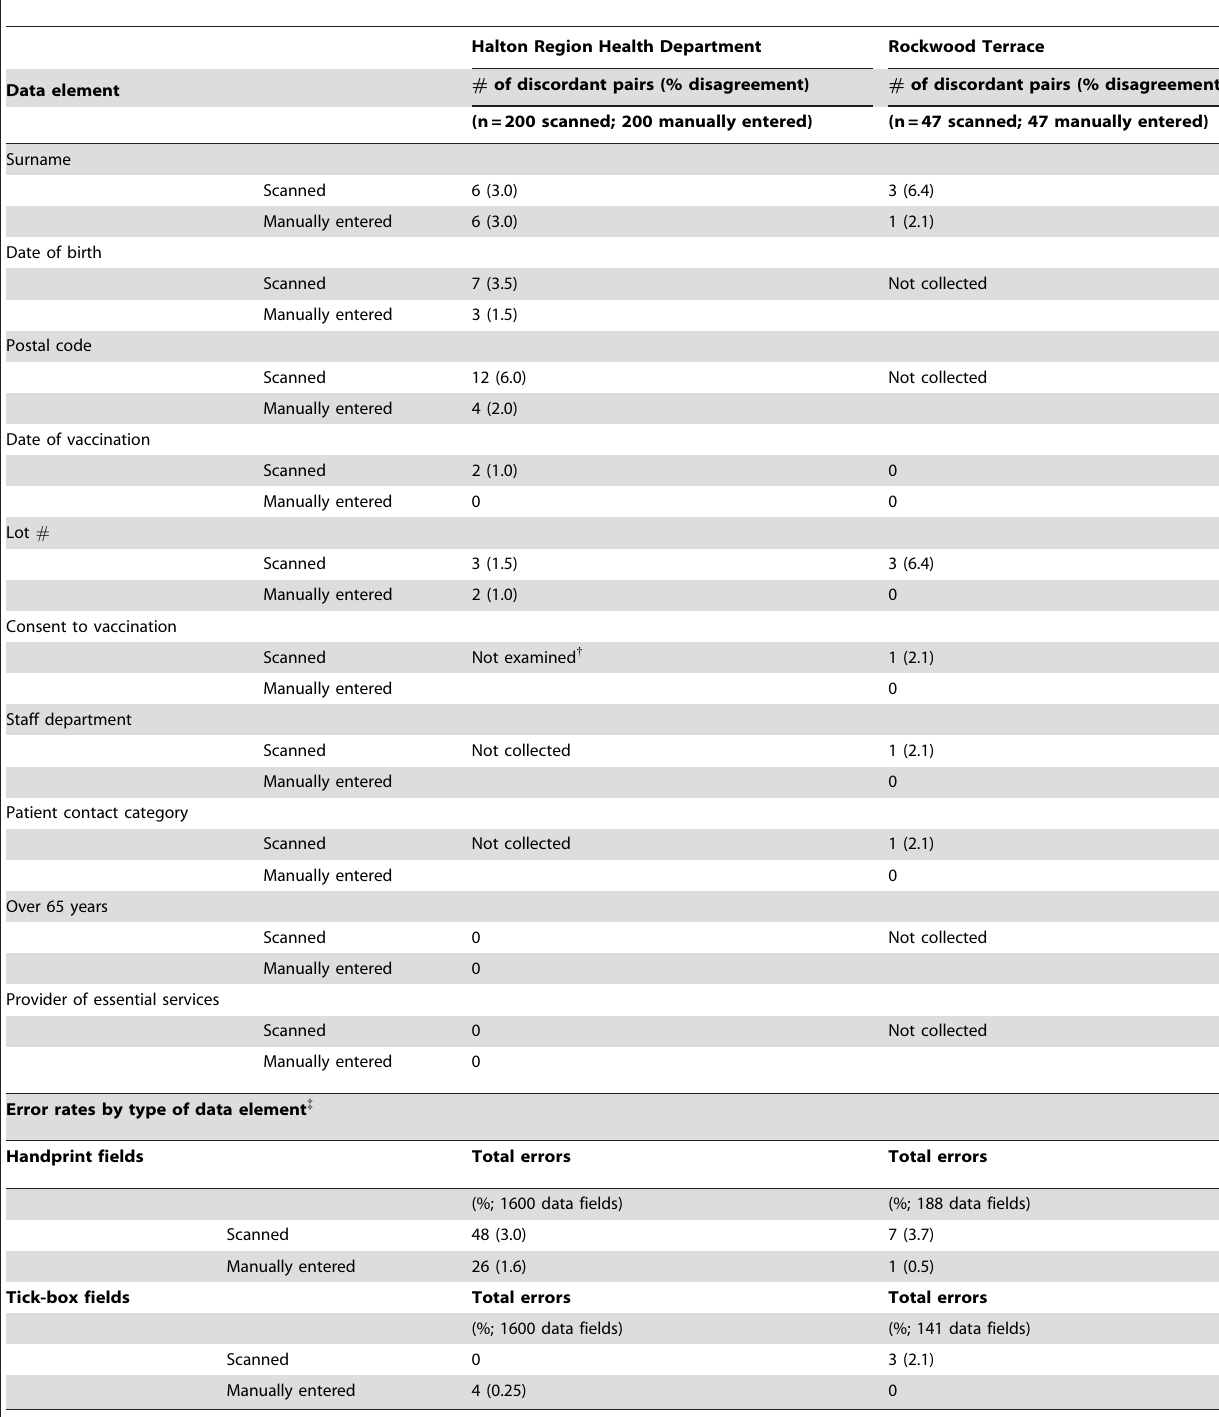
Table 2. Agreement between paper forms and electronic records by data entry